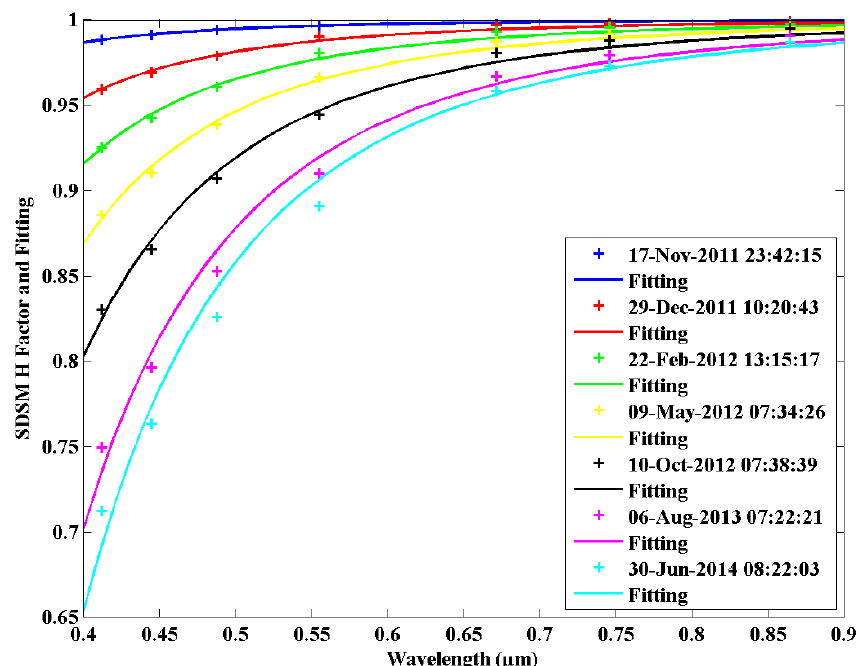
Figure 6. Fitting of VIIRS SD spectral reflectance with the SRRS reflectance correction model (Equation (8)) at several instants during 2.5 years operation of VIIRS.